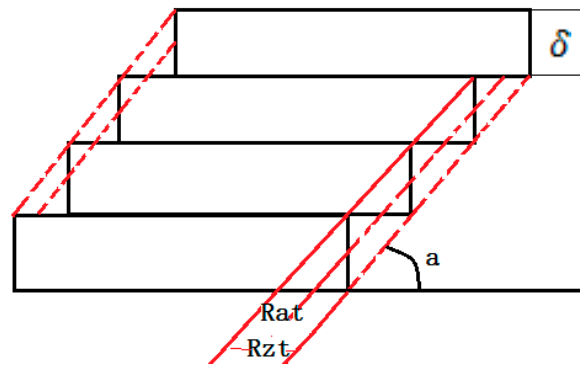
Figure 11. The surface roughness caused by the “stair stepping effect”.